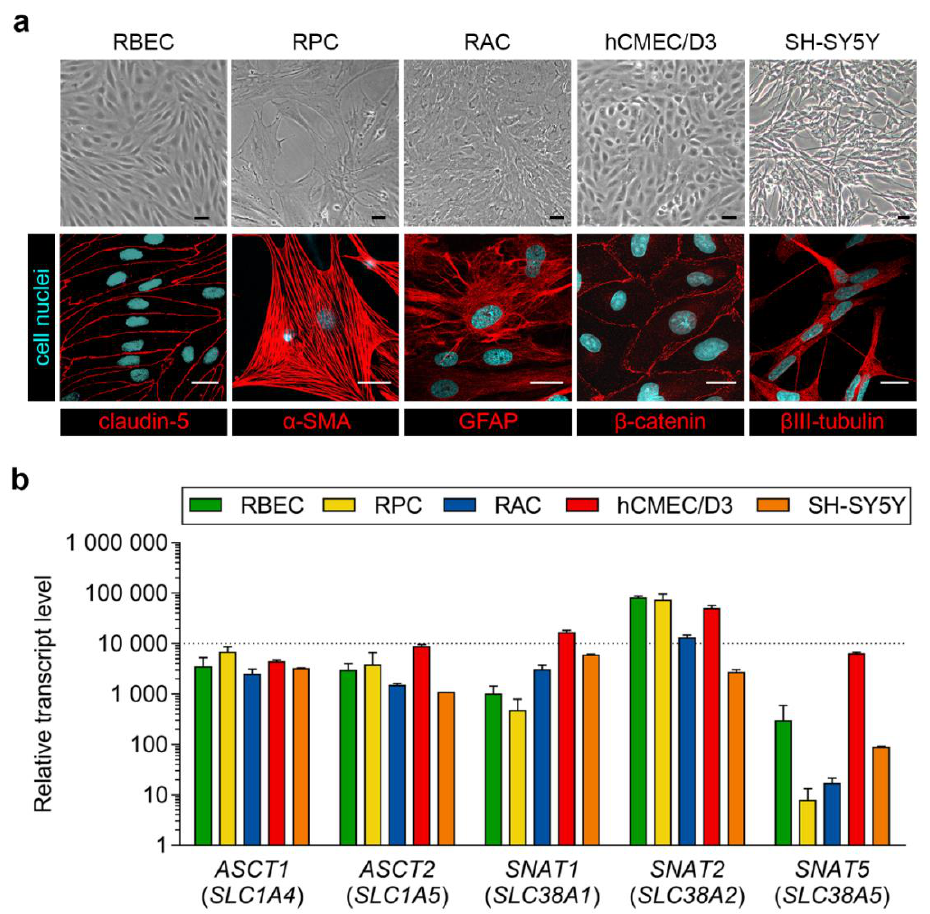
Figure 1. ( a ) Phase-contrast microscopy images and immunostainings of cultured primary rat brain endothelial cells (RBEC), primary rat pericytes (RPC), primary rat astrocytes (RAC), hCMEC / D3 human brain endothelial cells and SH-SY5Y human neurons. α -SMA: α -smooth muscle actin; GFAP: glial fibrillary acidic protein. Bar: 25 µ m. ( b ) Expression of genes encoding alanine transporters in the same cell types. RBEC and hCMEC / D3 data is shown with permission from [15]. Values presented are means ± SEM.